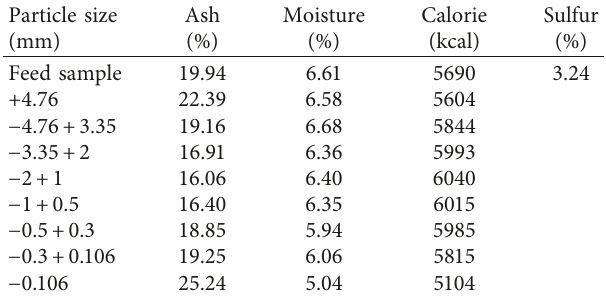
Table 5: Sample-C1 screen analysis: ash, moisture, and calorie values.